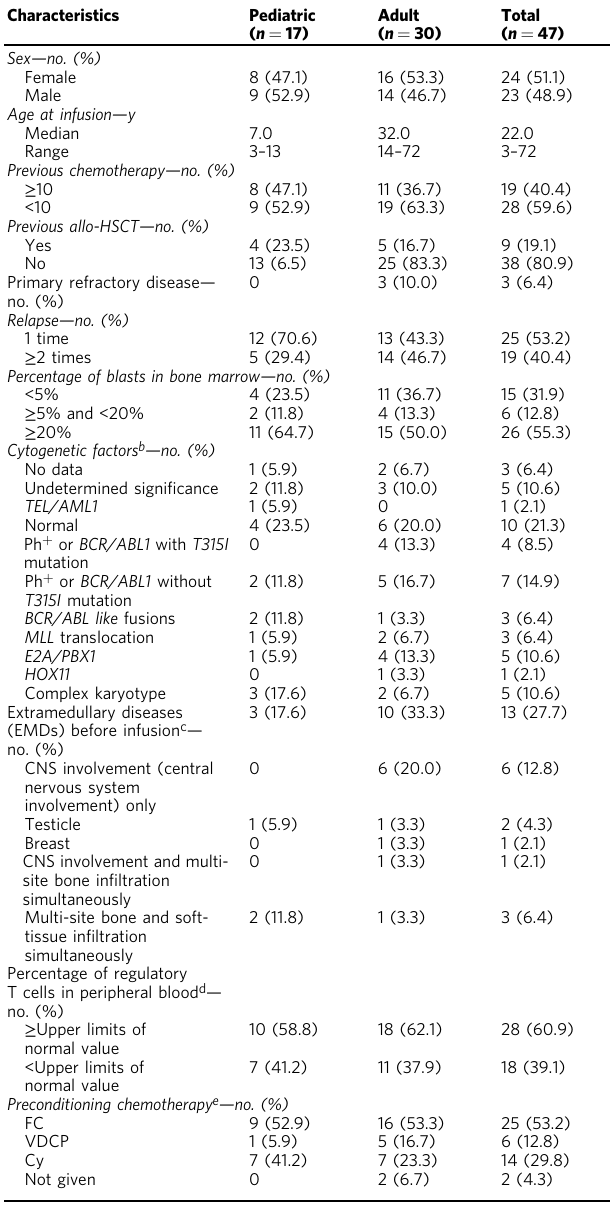
Table 1 Characteristics of evaluable patients a . Characteristics